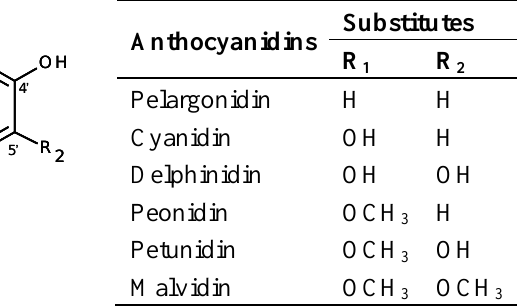
Figure 1. Structures of six common anthocyanidins occurring in Nature.